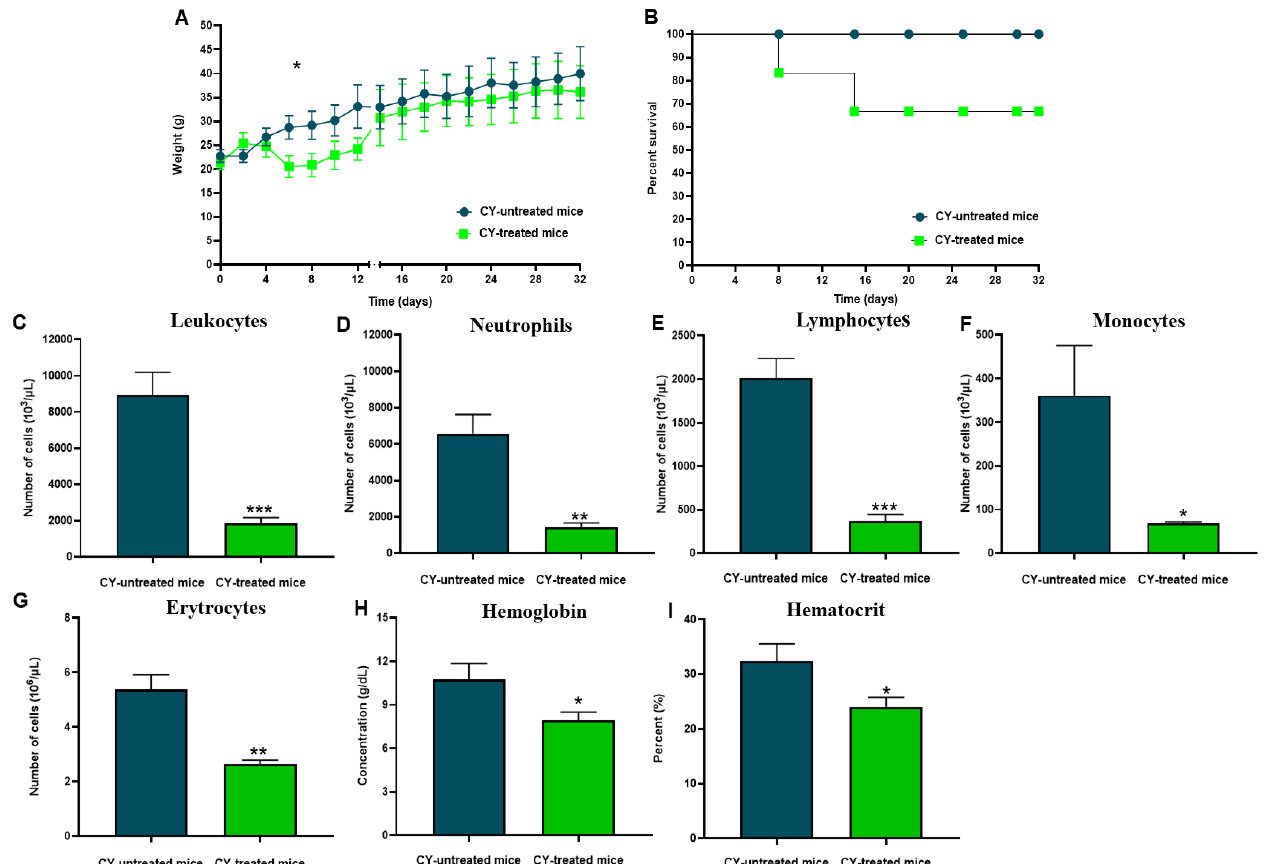
Figure 4. Description of the immunosuppressive model Swiss mice. ( A ) Bodyweight monitoring of CY-treated and CY- untreated mice using six animals per group. Data are expressed as the mean and standard deviation, (*) p < 0.05. ( B ) Percentage survival of CY-treated mice using cyclophosphamide (150 mg/kg). ( C ) Leukocyte numbers. (***) p < 0.001. ( D ) The number of neutrophils. (**) p < 0.01. ( E ) Several lymphocytes. (***) p < 0.001. ( F ) The number of monocytes. (*) p < 0.05. ( G ) Several erythrocytes. (**) p < 0.01. ( H ) Hemoglobin. (*) p < 0.05. ( I ) Hematocrit. (*) p < 0.05. p values were determined by the t -test.